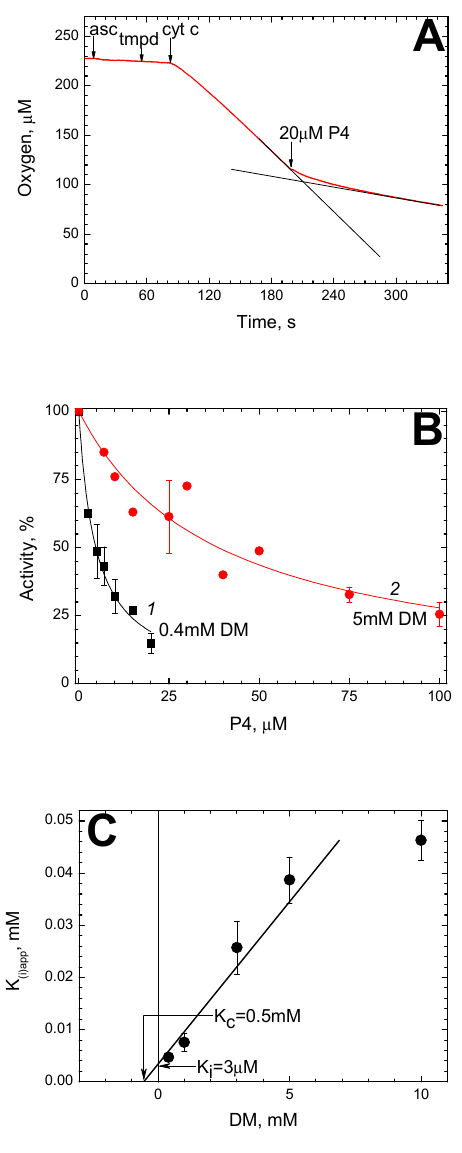
Figure 1. Inhibition of solubilized CcO by P4. The oxidase reaction was carried out in Basic Medium (BM) containing 20 nM mitochondrial CcO. ( A ) A typical trace of oxygen consumption. The addi- tions of oxidation substrate (ascorbate, N,N,N (cid:48) ,N (cid:48) -Tetramethyl- p -phenylenediamine (TMPD) and cytochrome c ) and the P4 peptide are shown by the arrows. To highlight the inhibitory effect, the trace in the absence of P4 is shown, as well as the straight line corresponding to the final rate of the reaction (black lines). ( B ) The dependence of the oxidase reaction rate on the P4 concentration in the presence of 0.4 mM dodecyl-maltoside (DM, black symbols) and 5 mM DM (red symbols). The experimental points are approximated by Equation (1) with different K i(app) parameters (see the text). ( C ) Dependence of K i(app) for P4 on DM concentration. The segment being cut off on the Y axis by the approximating straight line indicates the true K i value in the absence of DM. The segment being cut off on the X axis in its negative area indicates the value of dissociation constant for DM in the absence of P4, K c . Both intersections are pointed by the